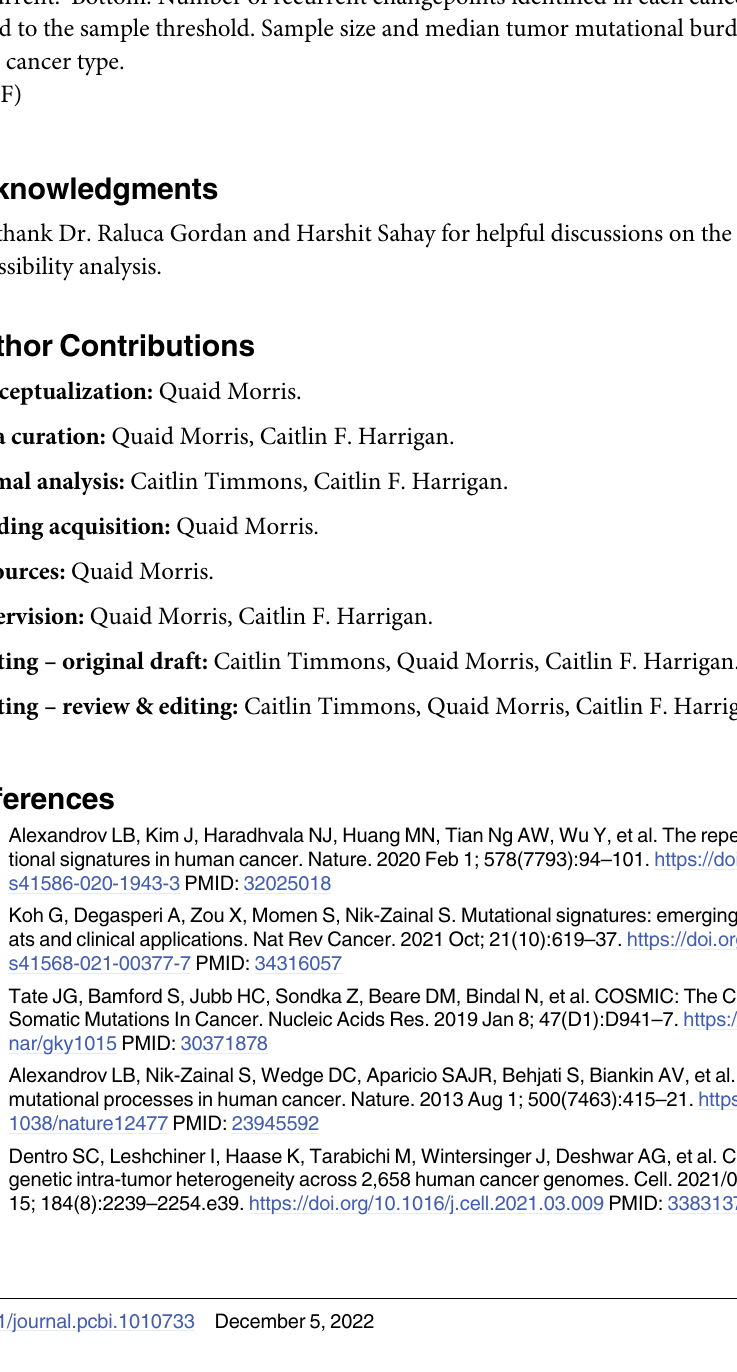
lines denote changepoints, and the opacity of changepoints represents their bootstrap support. (TIFF) S4 Fig. Lung-SCC changepoint density across the genome at four different bin sizes. Geno- meTrackSig was run genome-wise on 32 Lung-SCC samples with a bin size of either 100, 150, 200, or 300. Density plot across the genome of pooled changepoint positions in all samples is shown for each bin size analyzed. S5 Fig. Number of recurrent changepoints identified at different sample thresholds. Top: Number of recurrent changepoints identified across all cancer types depending on which number of samples is used as the threshold to determine which changepoints are considered ‘recurrent.’ Bottom: Number of recurrent changepoints identified in each cancer type com- pared to the sample threshold. Sample size and median tumor mutational burden is shown for each cancer